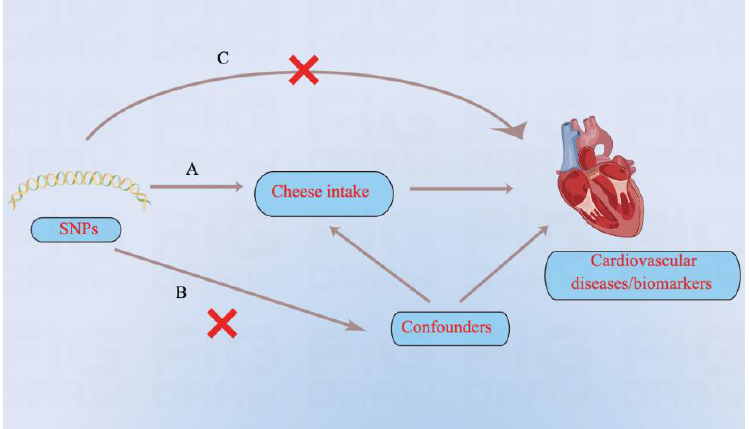
Figure 1. Three key assumptions of the Mendelian randomization study. (A) SNPs are strongly associated with cheese intake; (B) SNPs are independent of confounders; (C) SNPs must only affect cardiovascular diseases and biomarkers via cheese intake. SNP: single-nucleotide